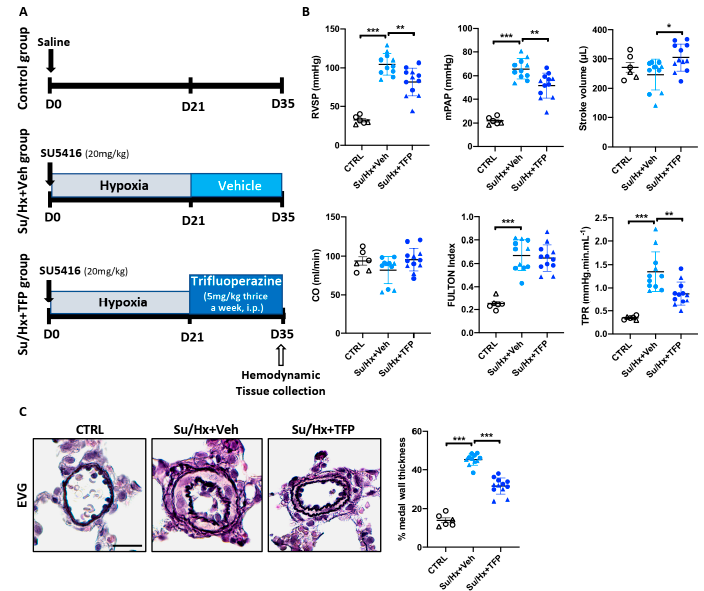
Figure 5 Figure 5. Effects of trifluoperazine (TFP) treatment on sugen/hypoxia (Su/Hx)-induced PAH in rats. ( A ) Schematic representation of the experimental design and schedule of the protocol. ( B ) Right ventricular systolic pressure (RVSP), mean pulmonary artery pressure (mPAP), stroke volume (SV), cardiac output (CO), Fulton index and total pulmonary resistance (TPR) were measured in control (CTRL), Su/Hx + vehicle (Veh) and Su/Hx + TFP rats; n = 6 to 12 rats/group. ( C ) Representative images of distal pulmonary arteries (PAs) stained with Elastica van Gieson (EVG). The graph on the right represents the degree of medial wall thickness. Data are presented as mean ± SEM and triangles represent females.